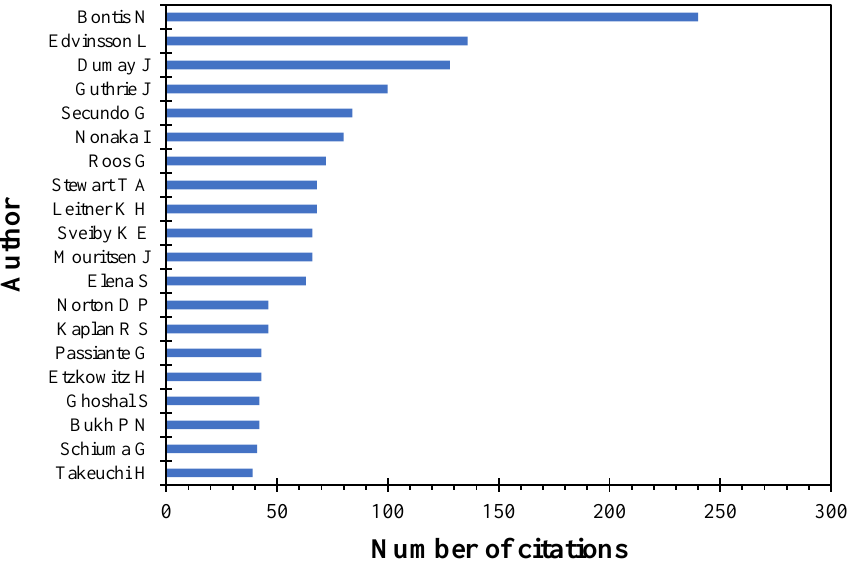
Figure 10. Relevance of the author by the number of citations.